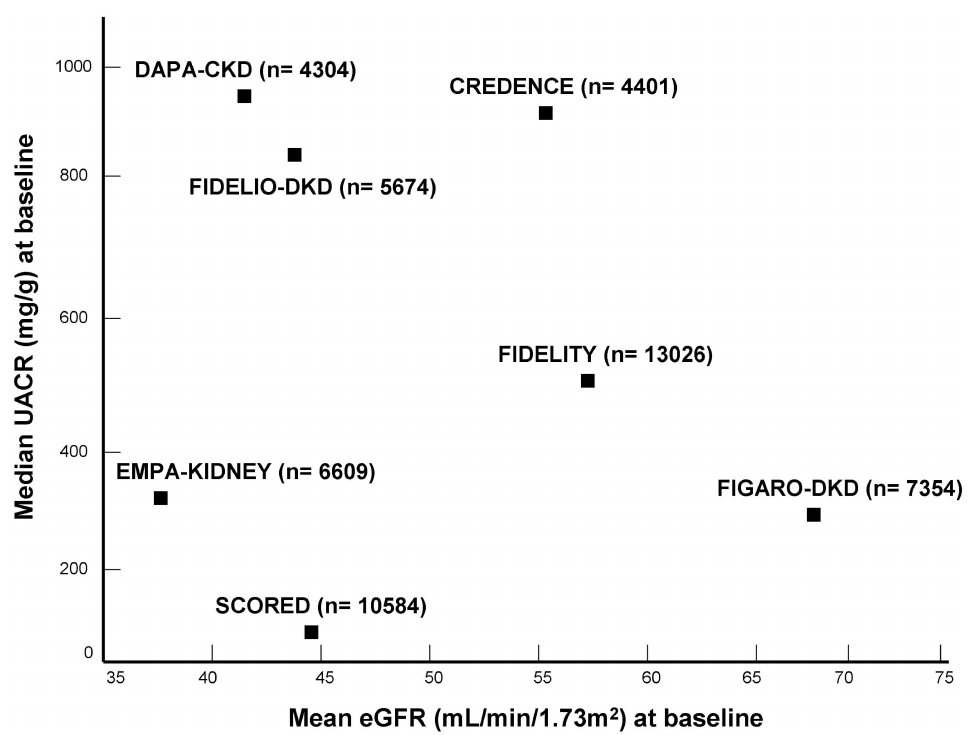
Figure 1. Overview of baseline median UACR and mean eGFR levels of patients enrolled in recent randomized trials that explored the treatment effects of SGLT-2 inhibitors and the nonsteroidal MRA finerenone in CKD associated with